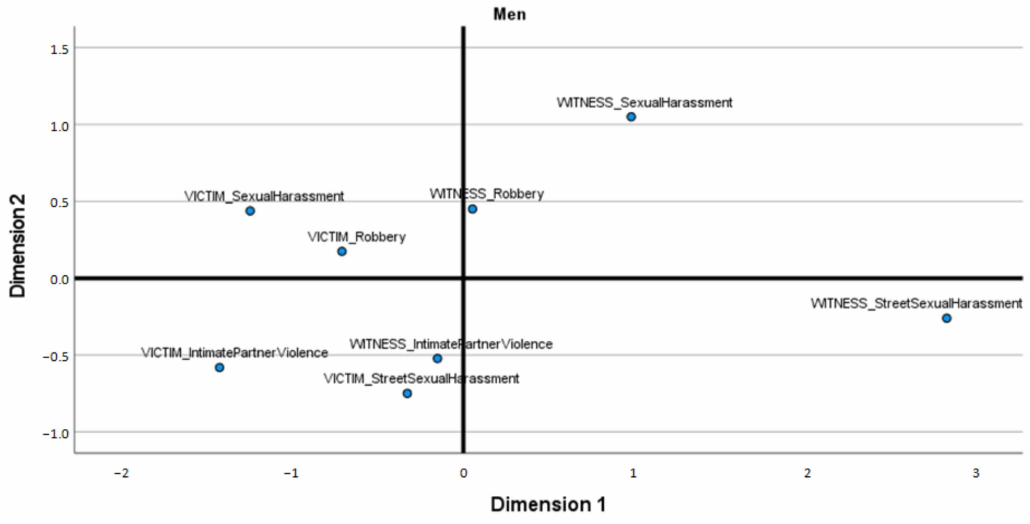
Figure 2. Multidimensional scaling of victimization types in